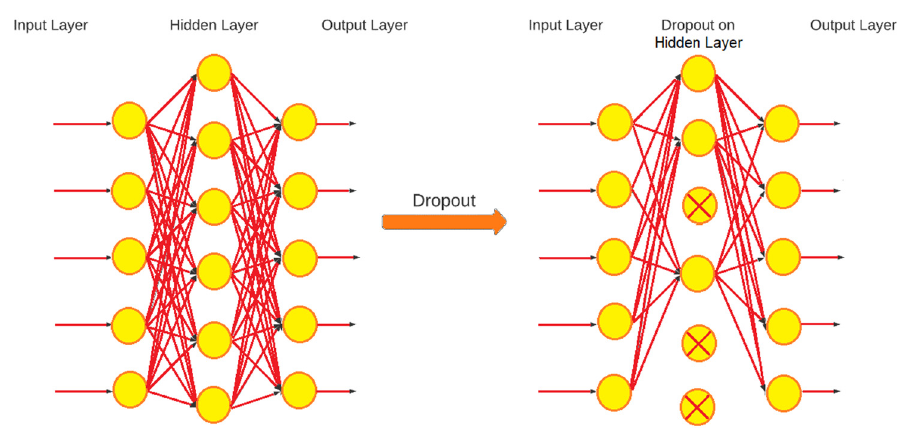
Figure 4. Comparison between before and after dropout of nodes.